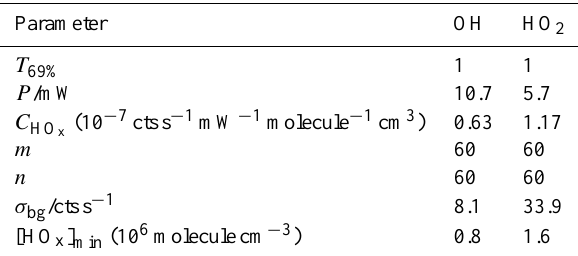
Table 1. Limit Of Detection (LOD) for a 60s integration calculated for a typical run on 17 August